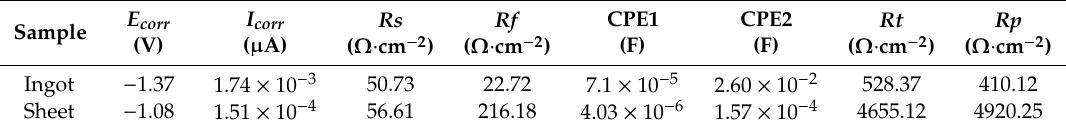
Figure 7. Electrochemical behaviors of the Mg-RE alloy ingot sample and the sheet with TRC sample in PBS solution: ( a ) polarization curves; ( b ) equivalent circuit and Nyquist plots of the real part Z (cid:48) vs. the imaginary part Z”; ( c ) Bode plots of | Z | vs. frequency; and ( d ) Bode plots of phase angle vs. frequency. Table 3. Result of the electrochemical polarization tests in PBS